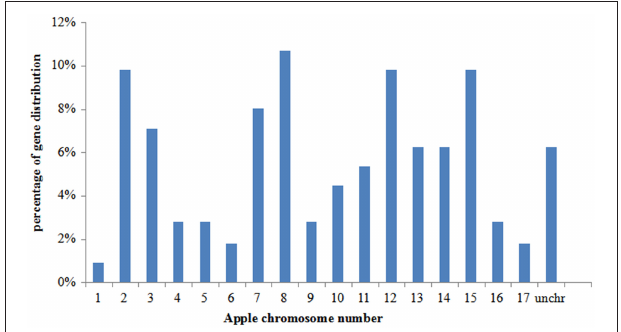
FIGURE 1 | The distribution of bZIP genes distribution on apple chromosomes, given as